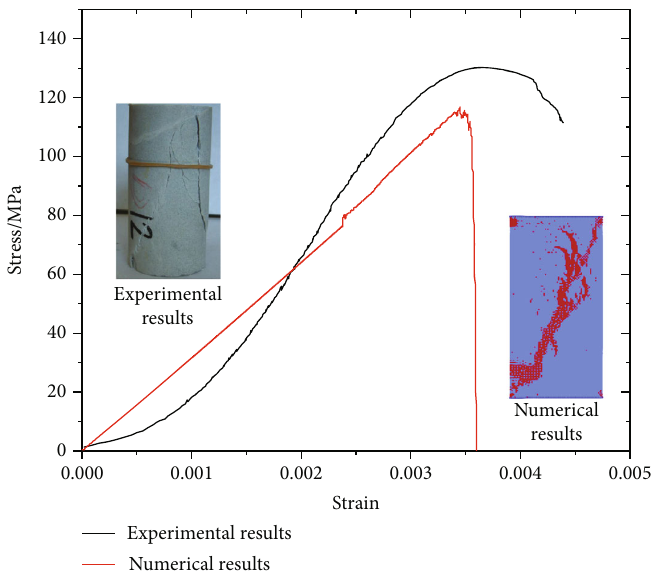
Figure 3: Comparisons between IKSPH results and previous experimental Table 1: Physical parameters of rock masses.